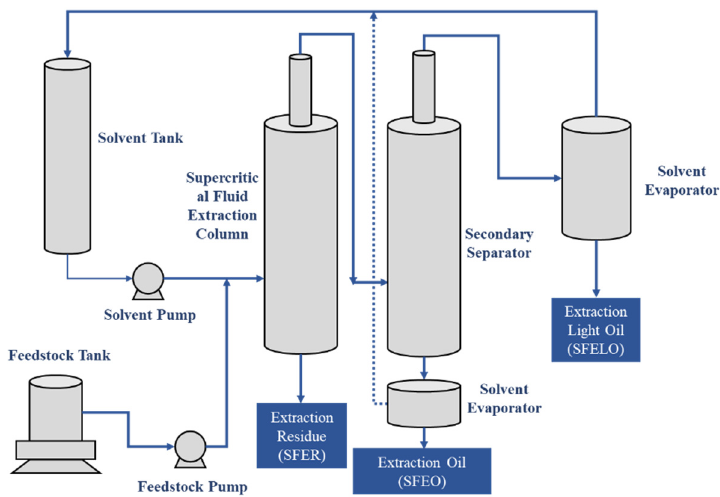
Figure 1. Flow chart of supercritical fluid extraction separation process.